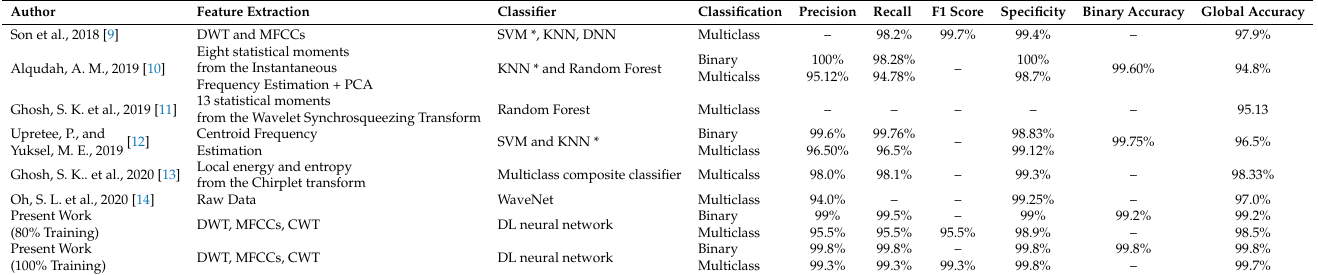
Table 3. Comparative table between works that used the same dataset. The DL algorithm that is proposed in the present work is mentioned twice, showing the results using 80% or 100% of the dataset as the training set. When more than one clasiffier was used, the best one (*) is